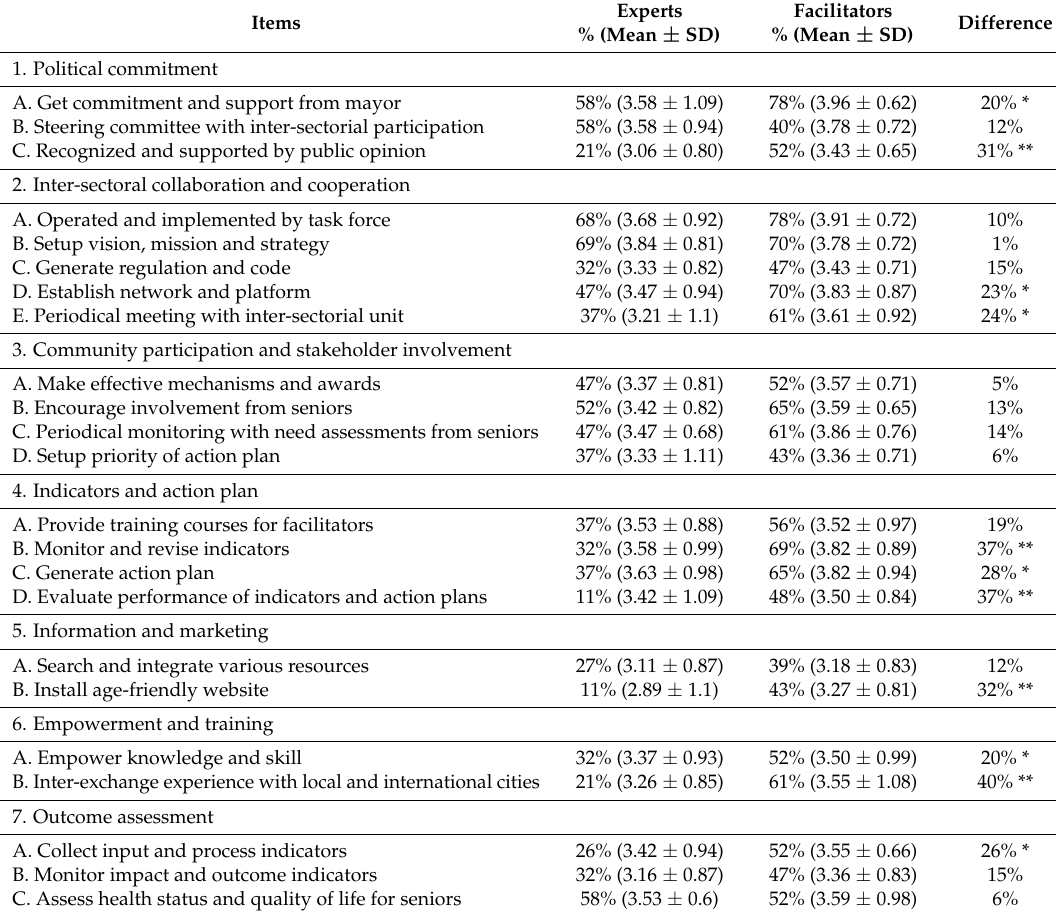
Table 2. Outcome evaluation ratings by experts and facilitators.